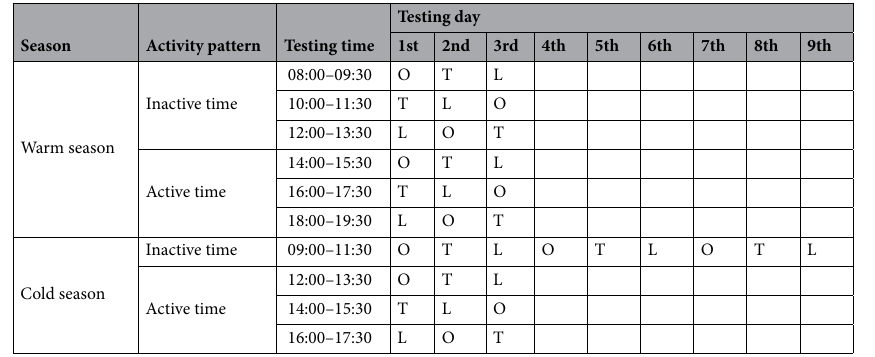
Table 2. Times of the experiments for each treatment in the active and inactive periods of plateau zokors during the warm and cold season. This table only represents the times of experiments for one individual from the six and three individuals used in these experiments in the warm and cold season, respectively. O, T and L represent the oxygen, temperature, and light treatments, respectively.